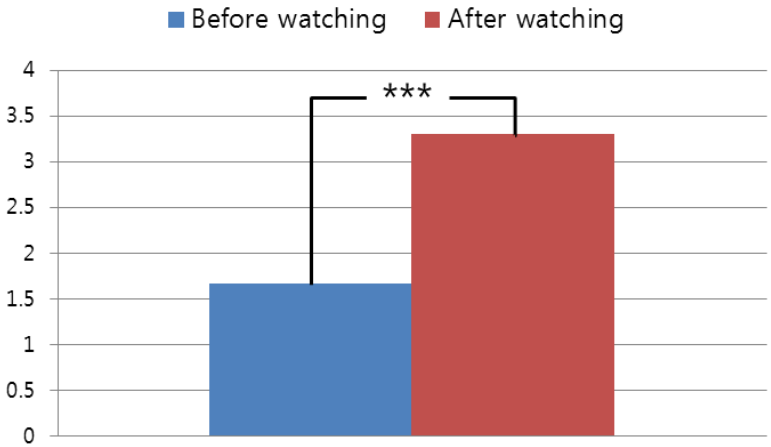
Figure 8. Result of subjective evaluation with the commercial 3D video of Table 1. (***: significant at a confidence level of p <